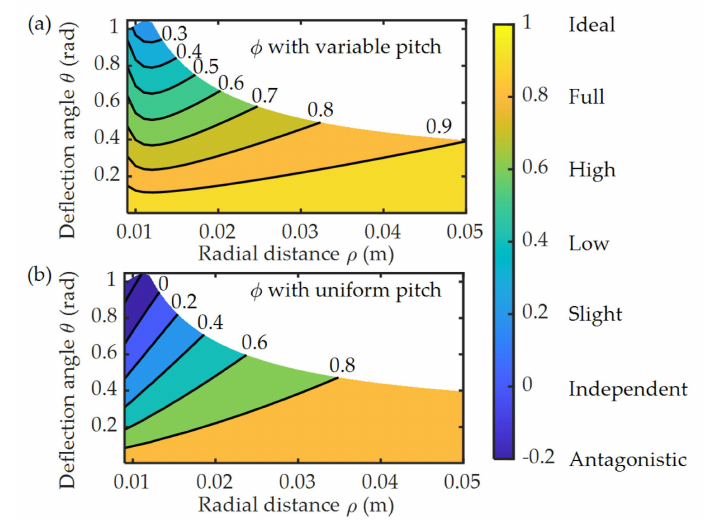
Figure 10. Load ratio comparison of configuration I (variable pitch vs. uniform pitch).